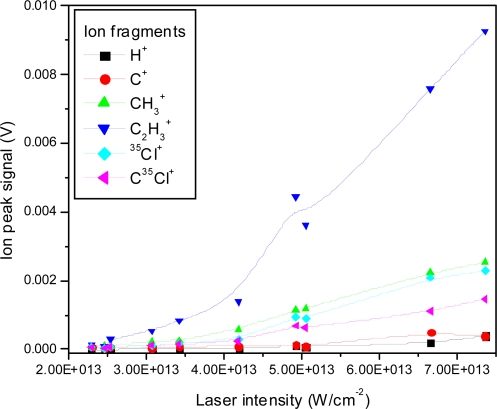
Ion peak signals as a function of laser intensity for H+, C+, CH3+, C2H3+, 35Cl+, C35Cl+ fragment ions using 397 nm laser radiation with 150 fs pulse duration.